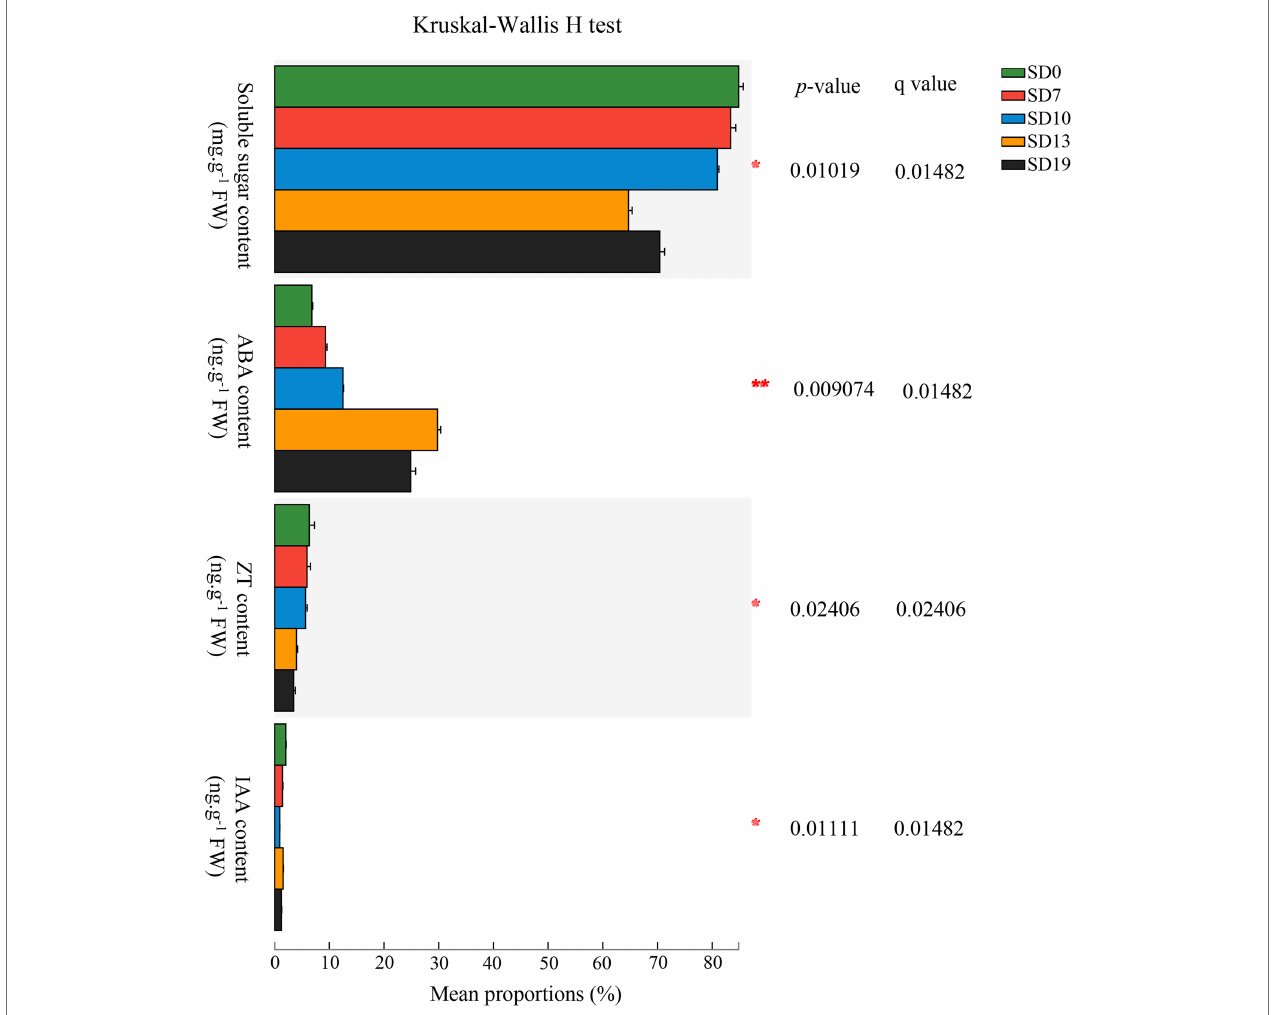
FIGURE 3 | Luculia gratissima endogenous soluble sugar content and hormonal changes, shoot apexes and leaves at five stages upon short-day treatment. The y-axis shows soluble sugar and four hormones, and the x-axis shows the average relative abundance of the endogenous soluble sugars and hormones. Colored columns represent different developmental stages. *0.01 < p ≤ 0.05; **0.001 < p ≤